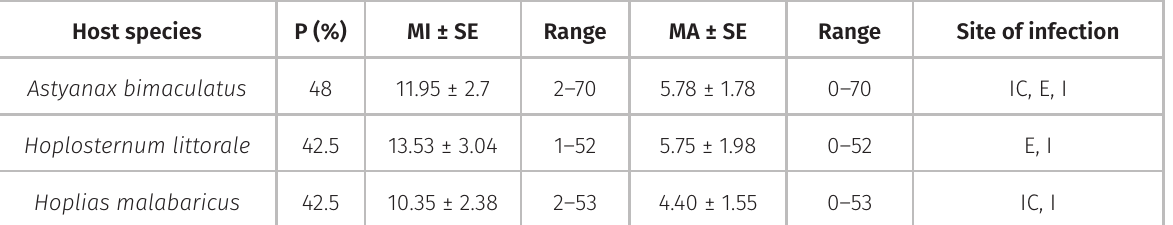
Table II. Prevalence (P(%)), mean intensity of infection (MI) and mean abundance of infection (MA) with the respective site of infection (IC = intestinal cecum, I= intestine, E = stomach) of larvae of Spiroxys sp. parasitizing three hosts species in Carás stream municipality of Crato, Ceará state, Brazil.